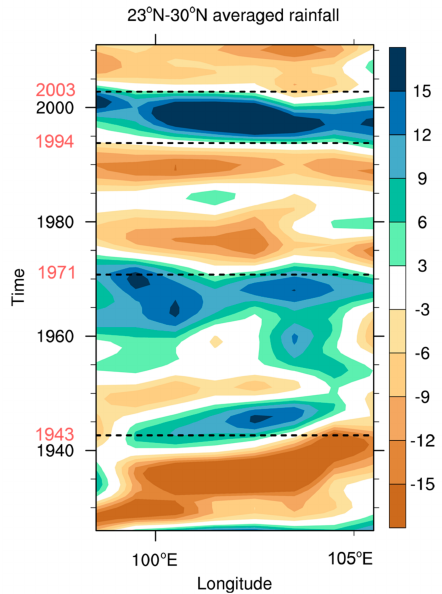
Figure 2. Longitude-time cross-section of the anomalous Southwestern China summer rainfall (SWCSR) for the period of 1926 to 2011 averaged between 23 ◦ N and 30 ◦ N using the Global Rainfall Climatology Centre (GPCC) datasets. An 11-year filter was applied. Dashed lines denote the transition years between drought and flood